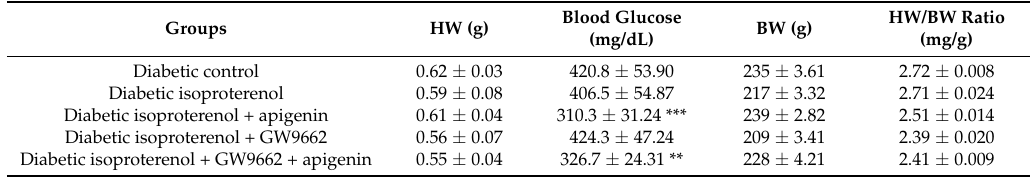
Table 1. Effect of apigenin on blood glucose and weights in different experimental groups.